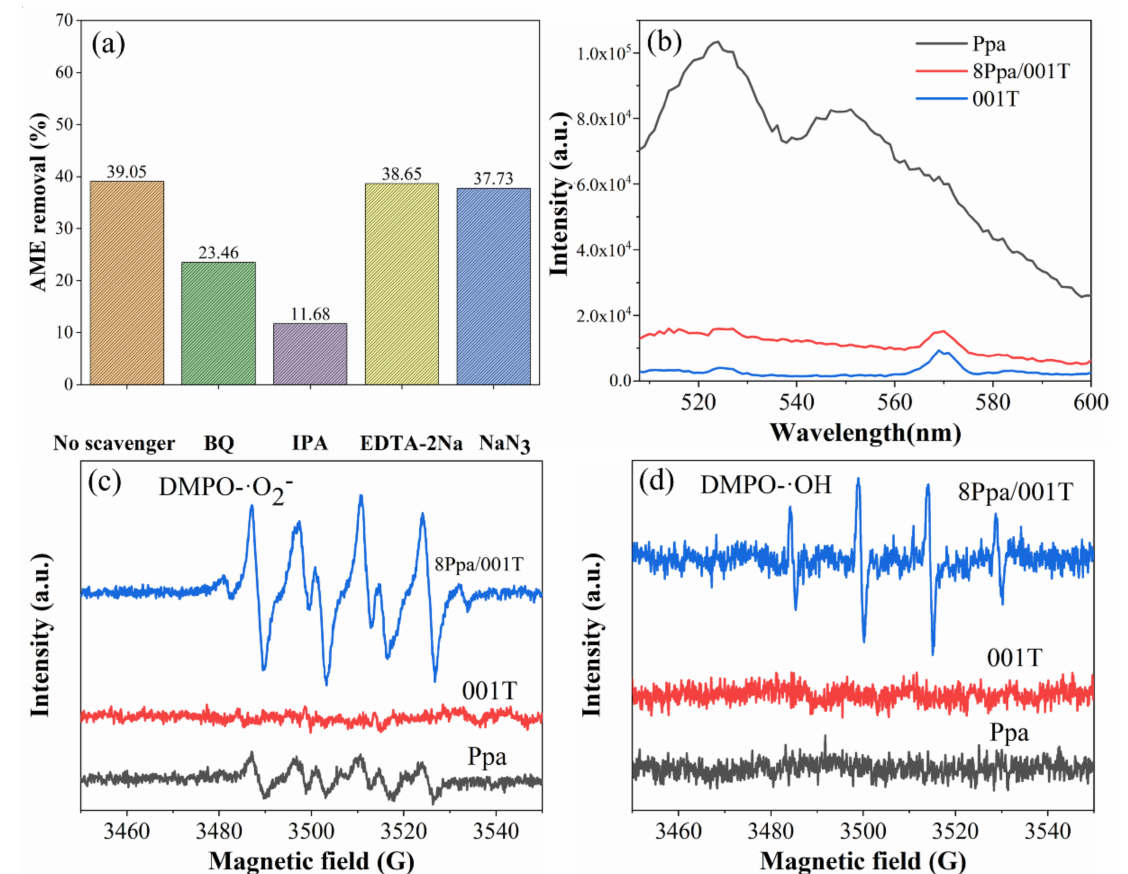
Figure 6. ( a ) Scavengers trapping experiments over the 8Ppa/001T sample; ( b ) Fluorescent probe results of the singlet oxygen; ( c ) The electron-spin resonance (ESR) tests for the detection of